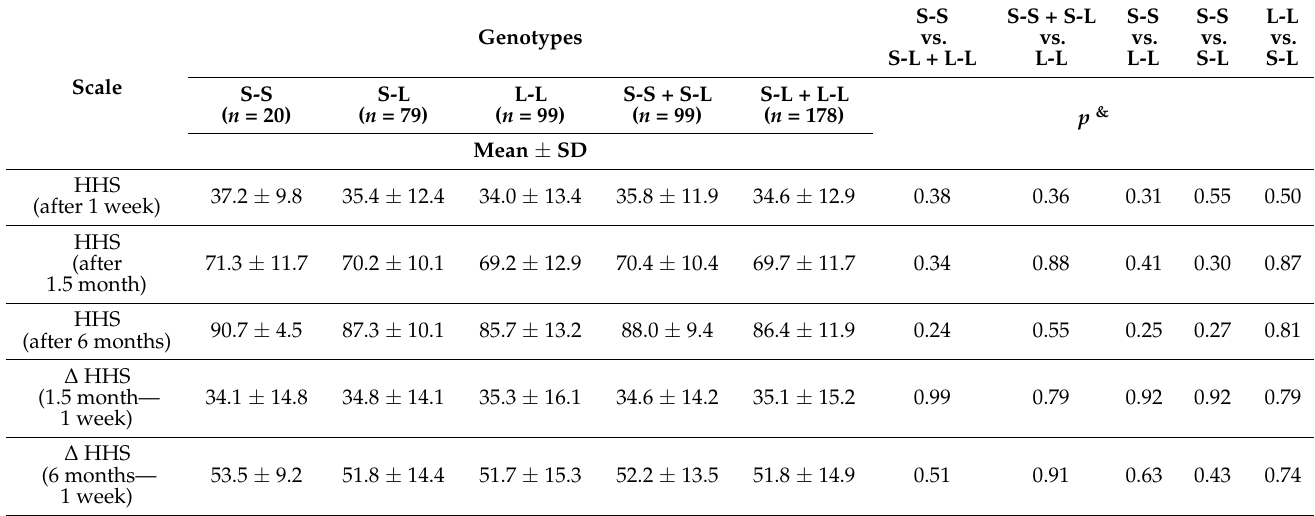
Table 7. Association of CNR1 genotype with hip function assessment in patients at defined intervals.